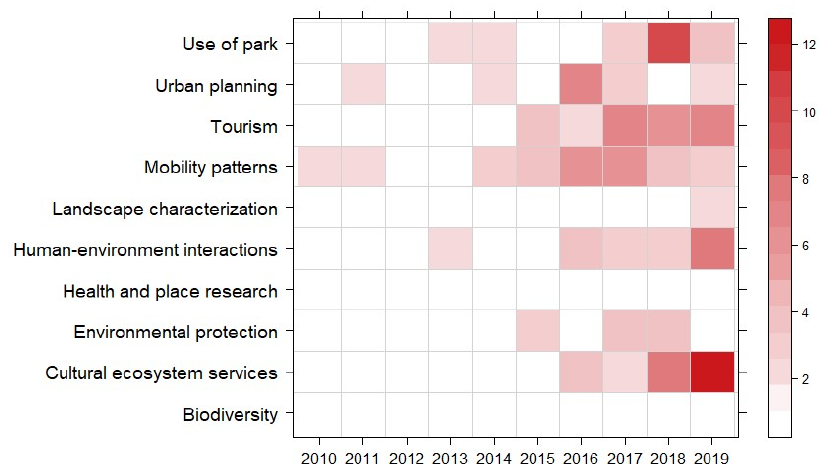
Figure 5. Research topics covered by research using social media and